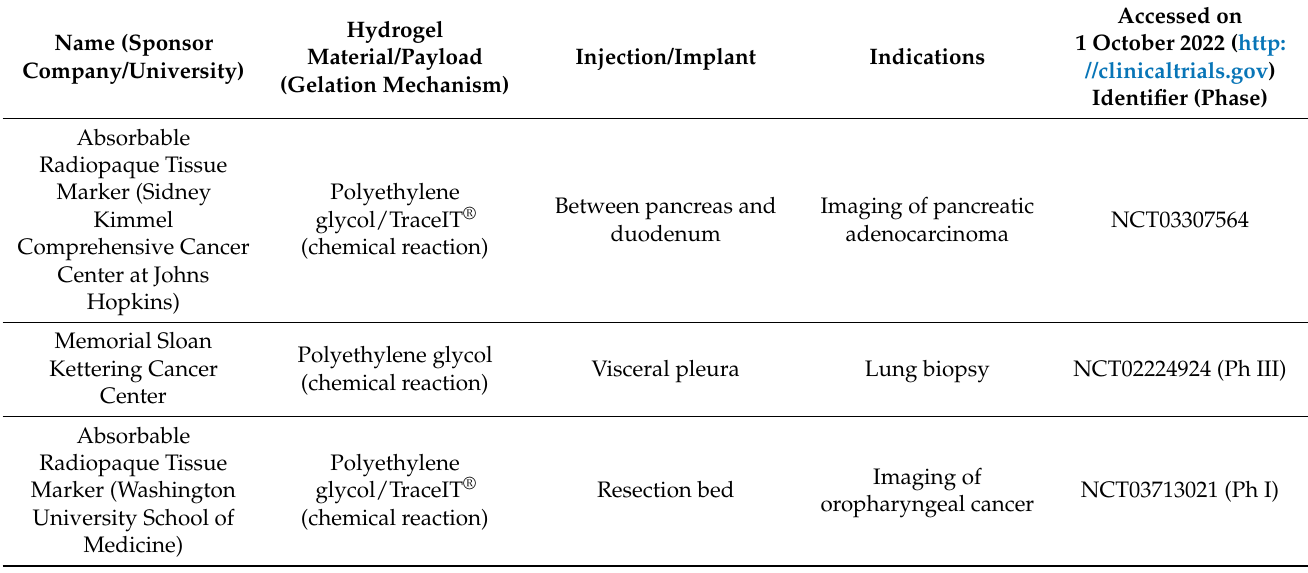
Table 4. Examples of the current scaffolds/hydrogels in clinical trials for cancer treatment (modified and reproduced under the terms of the Creative Commons CC BY license)